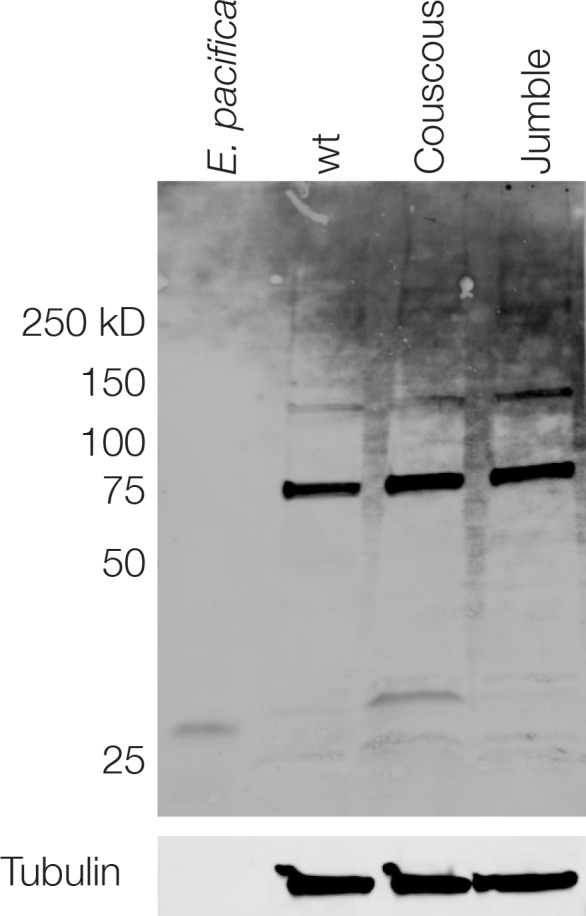
Jacalin Western blot in cell lysates.Whole cell lysates from E. pacifica (co-cultured prey bacteria), wild type S. rosetta, Couscous, and Jumble were probed with jacalin. No clear differences in banding pattern were observed among the S. rosetta strains, except for a small band ~25 kD in the Couscous lysate that is likely from E. pacifica contamination. Tubulin was probed as a loading control.